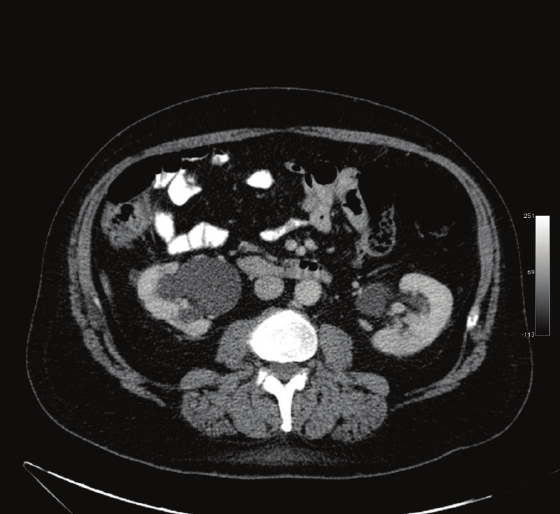
Figure 2: Abdominal computerized tomography revealing a right kidney